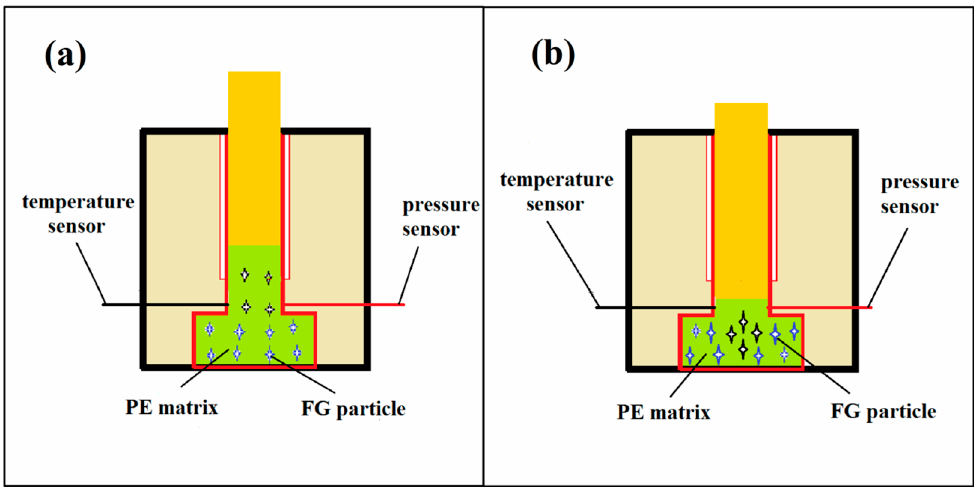
Figure 2. Schematic diagram of the molding process using twice melting and extruding method: ( a ) extrude the solid powders and heat at 523 K for 60 min and ( b ) press the molten mixtures at 20 MPa and then heat at 423 K for 30 min.